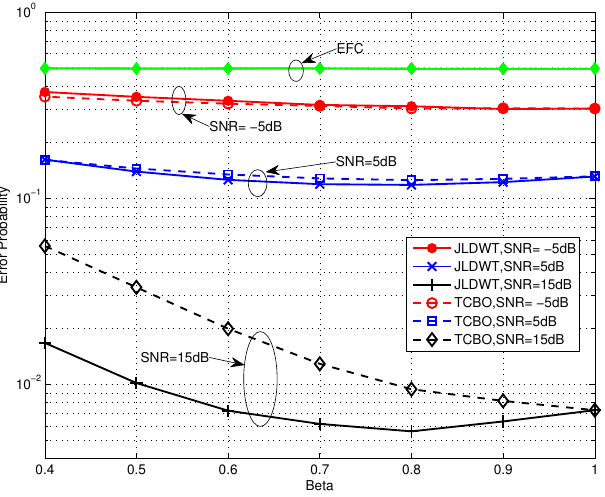
Figure 11. Error probabilities of TCBO and JLDWT schemes with SC based LLR as functions of various β for snr L = 5